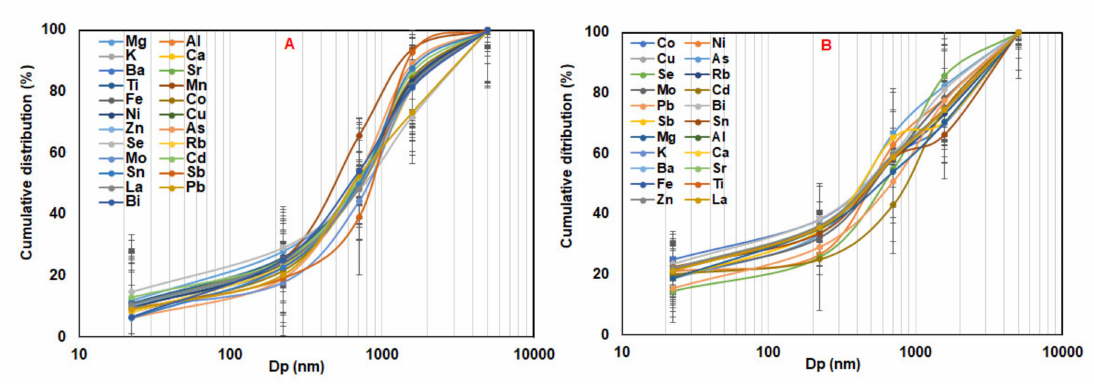
Figure 9. Cumulative size-resolved elemental distributions of indoor airborne particles sampled during the class at S1 ( A ) and S2 ( B ). n = 80, average ±